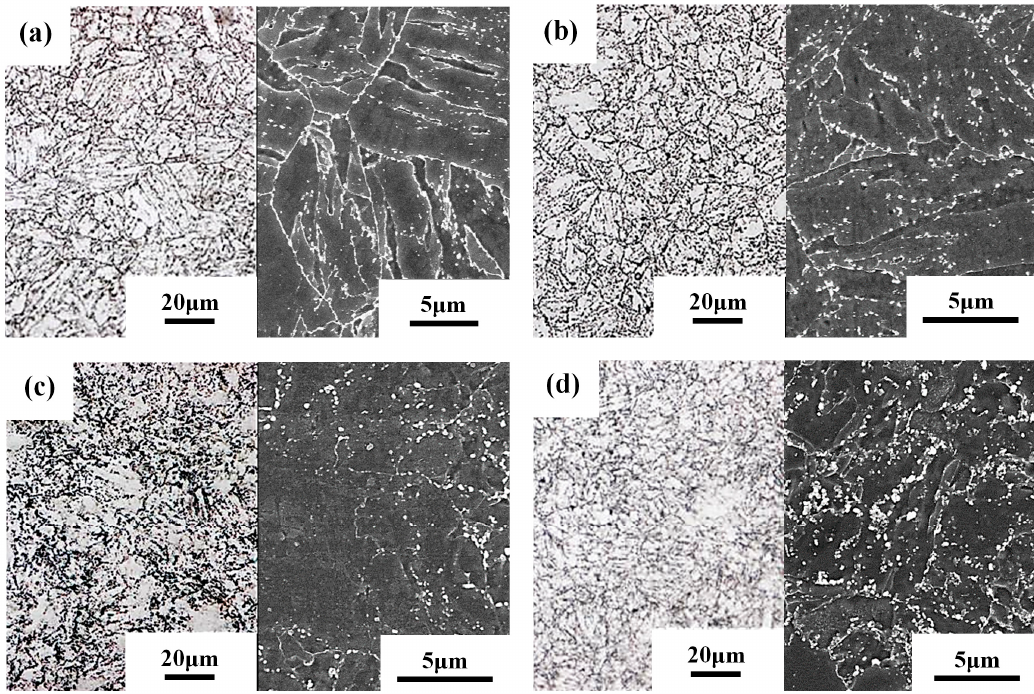
Figure 2. Optical (left) and SEM (right) micrographs of the: ( a ) BM; ( b ) STOT; ( c ) ICHAZ; and ( d ) FGHAZ specimens after PWHT.